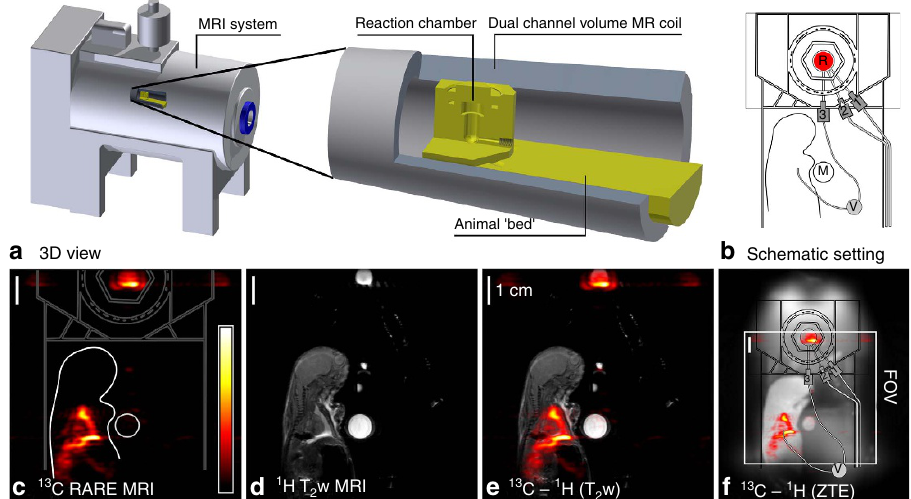
Figure 7 | Simultaneous 13 C-HP and ex vivo imaging: The compact design of the setup enabled SAMBADENA next to a small rat post mortem in the sensitive volume of the magnet ( a , b ). Within seconds, the 13 C-tracer HEP was polarized to B 17% at a concertation of 22mM. Without leaving the magnet, B 330 m l of the tracer were injected into the rat, and strong 13 C signal with a maximum SNR of 113 was observed by MRI acquired in 0.5s ( c ). Subsequently, a T 2 -weighted 1 H-MRI ( d ) and 1 H Zero-Echo-Time (ZTE) MRI were recorded. Co-registration of 1 H and 13 C-data revealed the location of the tracer, in the reaction chamber and surrounding the heart of the animal ( e , f ). The isocenter of the magnet is the center of the images. R, reactor; FOV, field of view; M, Model Solution M3; 1, 2, 3: lines for pressure relieve, p H 2 supply and p H 2 injection,